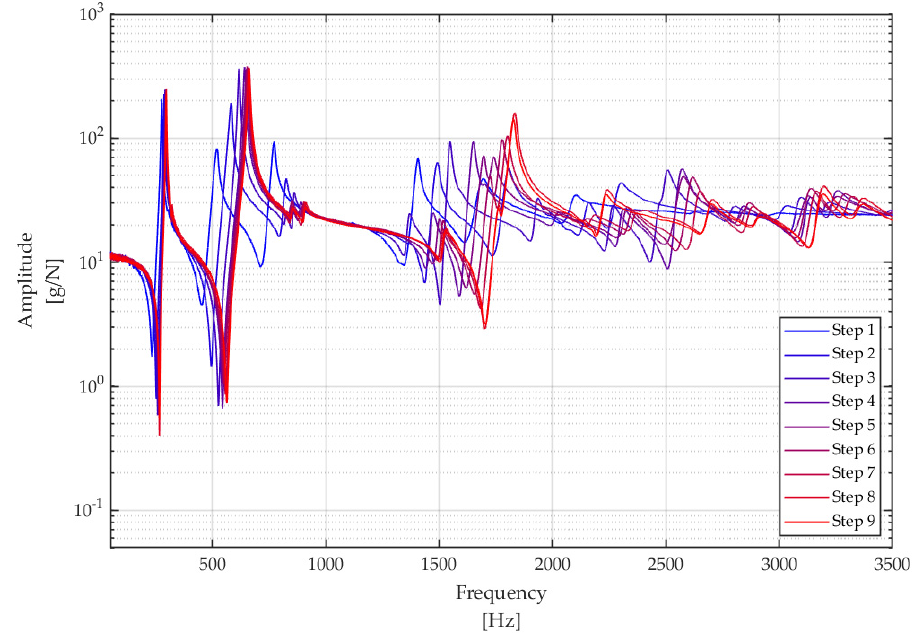
Figure 4. Comparison of FRFs corresponding to subsequent insertion steps without soft tissue in the AP direction.